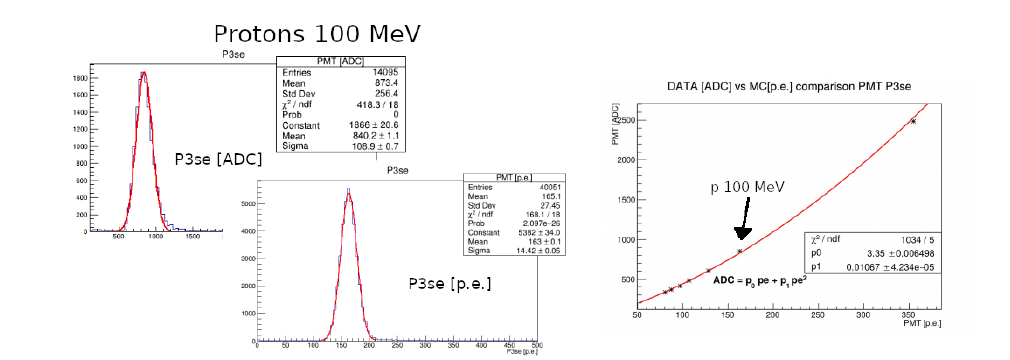
Figure 4. Left: distributions of ADC signal and p.e. (photo electrons) from PMT P3se in the 100 MeV proton run; both distributions were fitted with a gaussian; Right: peak of ADC signal as a function of light collected from PMT P3se in all proton runs; the curve was fitted with a